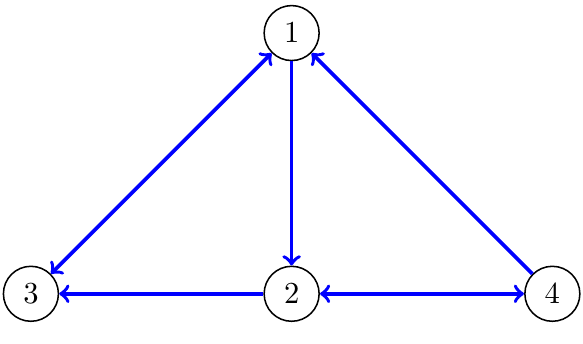
Figure 1. Communication